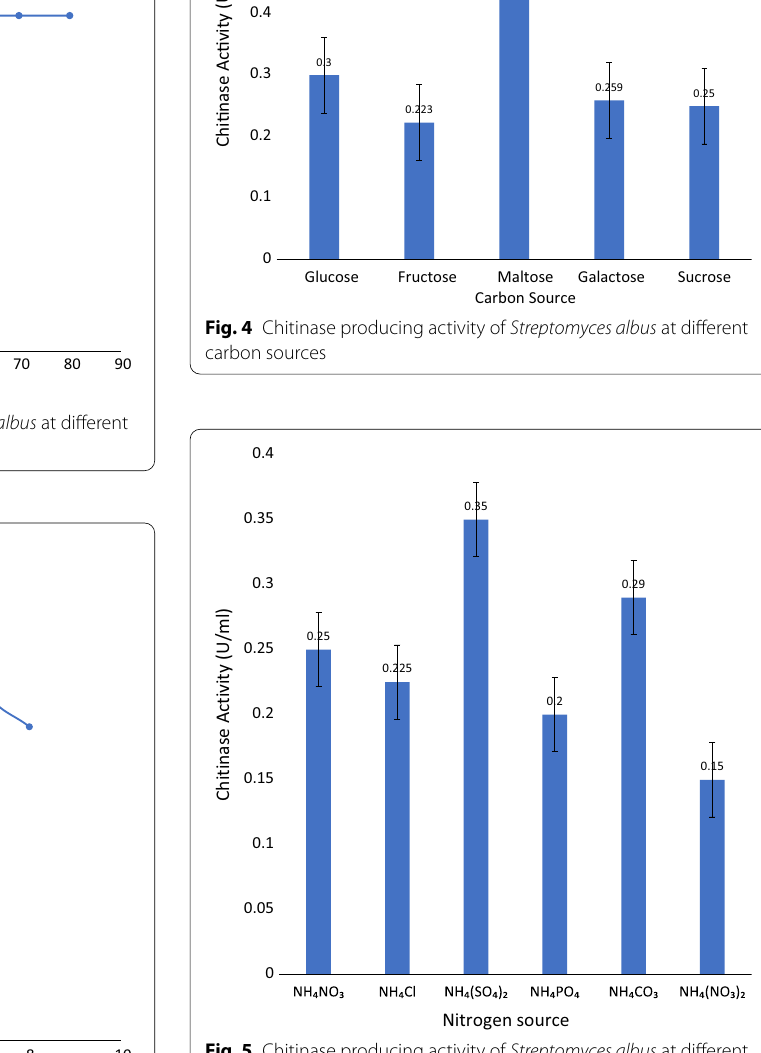
Fig. 5 Chitinase producing activity of Streptomyces albus at different nitrogen Fig. 3 Chitinase producing activity of Streptomyces albus at different pH a spectrophotometer. The fractions with chitinase activ- ity were combined, dialyzed against the acetate buffer (50 mM, pH 5.0), and concentrated by lyophilization The dialyzed sample was washed with the acetate buffer (Matsumae et al. 2000). after it was loaded on a pre-equilibrated DEAE-cellulose column chromatography (2.6 20 cm). The proteins were × eluted in a stepwise gradient on NaCl (0–1.0 M) at a flow rate of 24 ml/h and the absorbance was read at 280 nm in